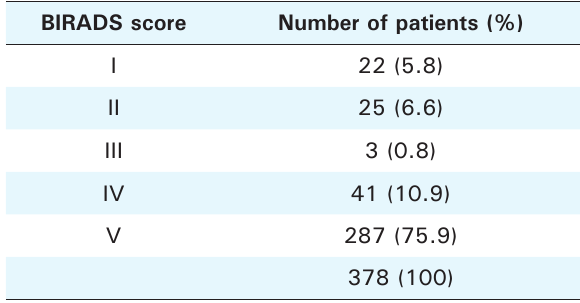
table 1. bIrAds score of patients who had undergone surgery